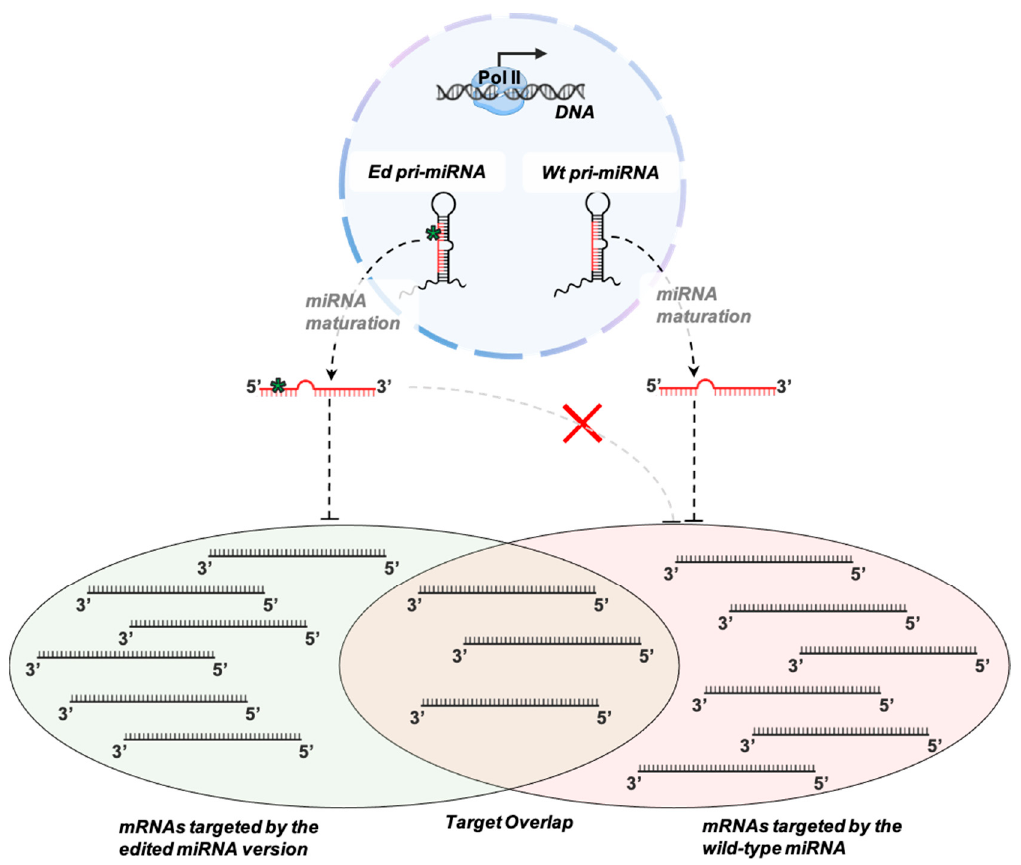
Figure 3. Schematic illustration of miRNA retargeting caused by editing of mature miRNAs. RNA editing can affect the miRNA-mediated modulation of gene expression by modifying the primary structure of wild-type (Wt) mature miRNAs. Such an event generates edited (Ed) miRNAs, often destroying their base-pairing with several complementary regions in the 3 ′ UTRs of their original targets and creating complementarity for new targets. However, both the Wt and Ed miRNAs seem to share a subset of their target mRNAs.